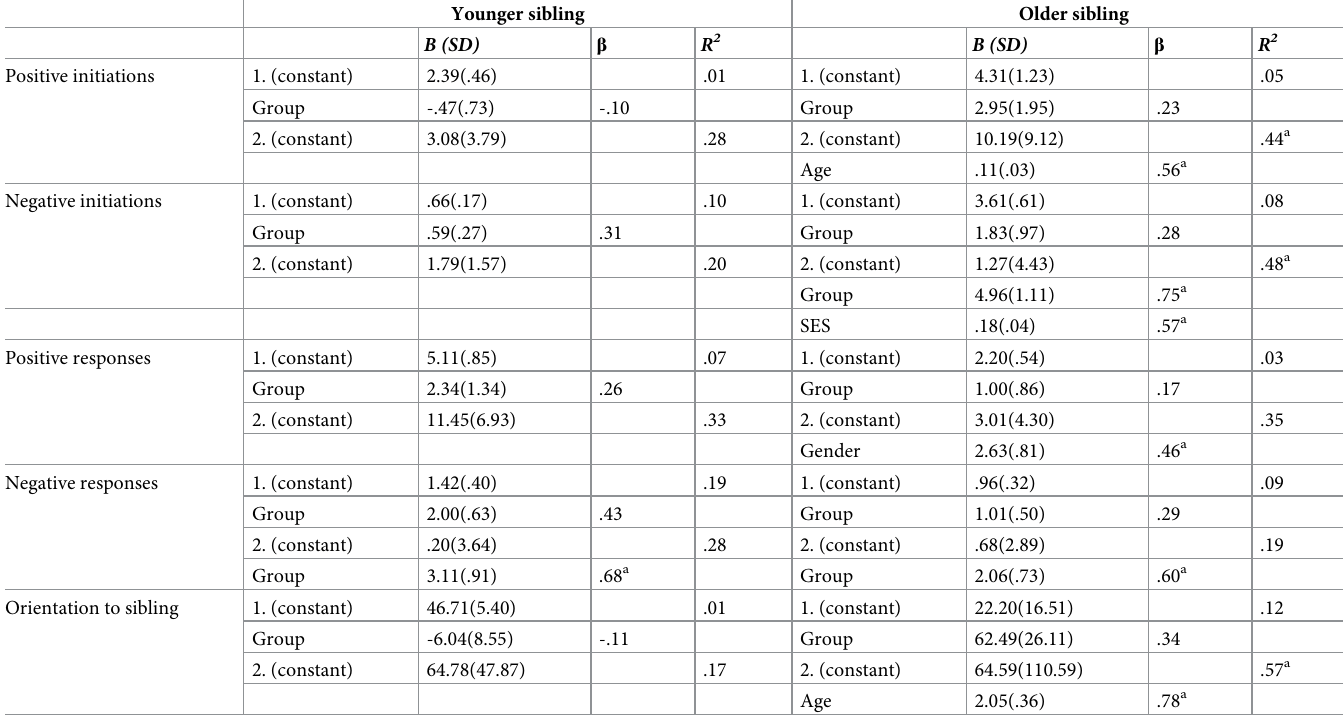
Table 3. Regression coefficients for significant predictors—Marble